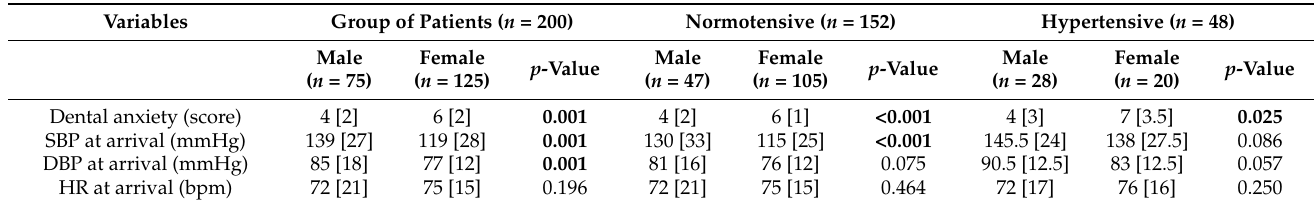
Table 4. Comparisons of study variables between sexes (Median [IQR]).